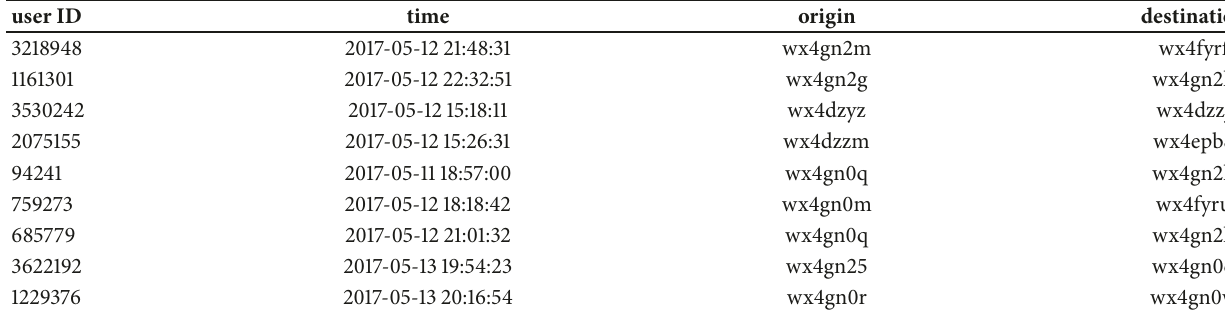
Table 3: Behaviors of user 2730 in 11th to 13th May.